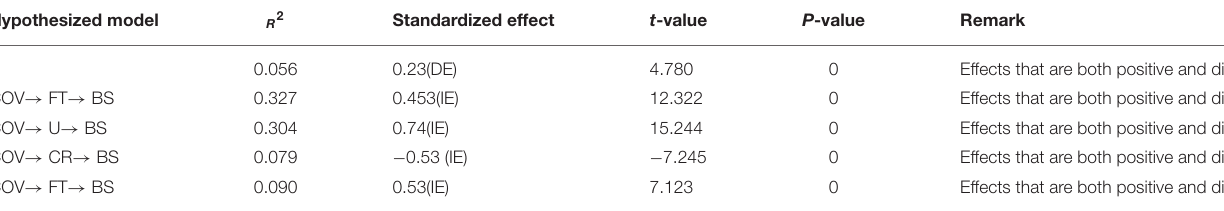
TABLE 5 | Model of the hypothesized testing.